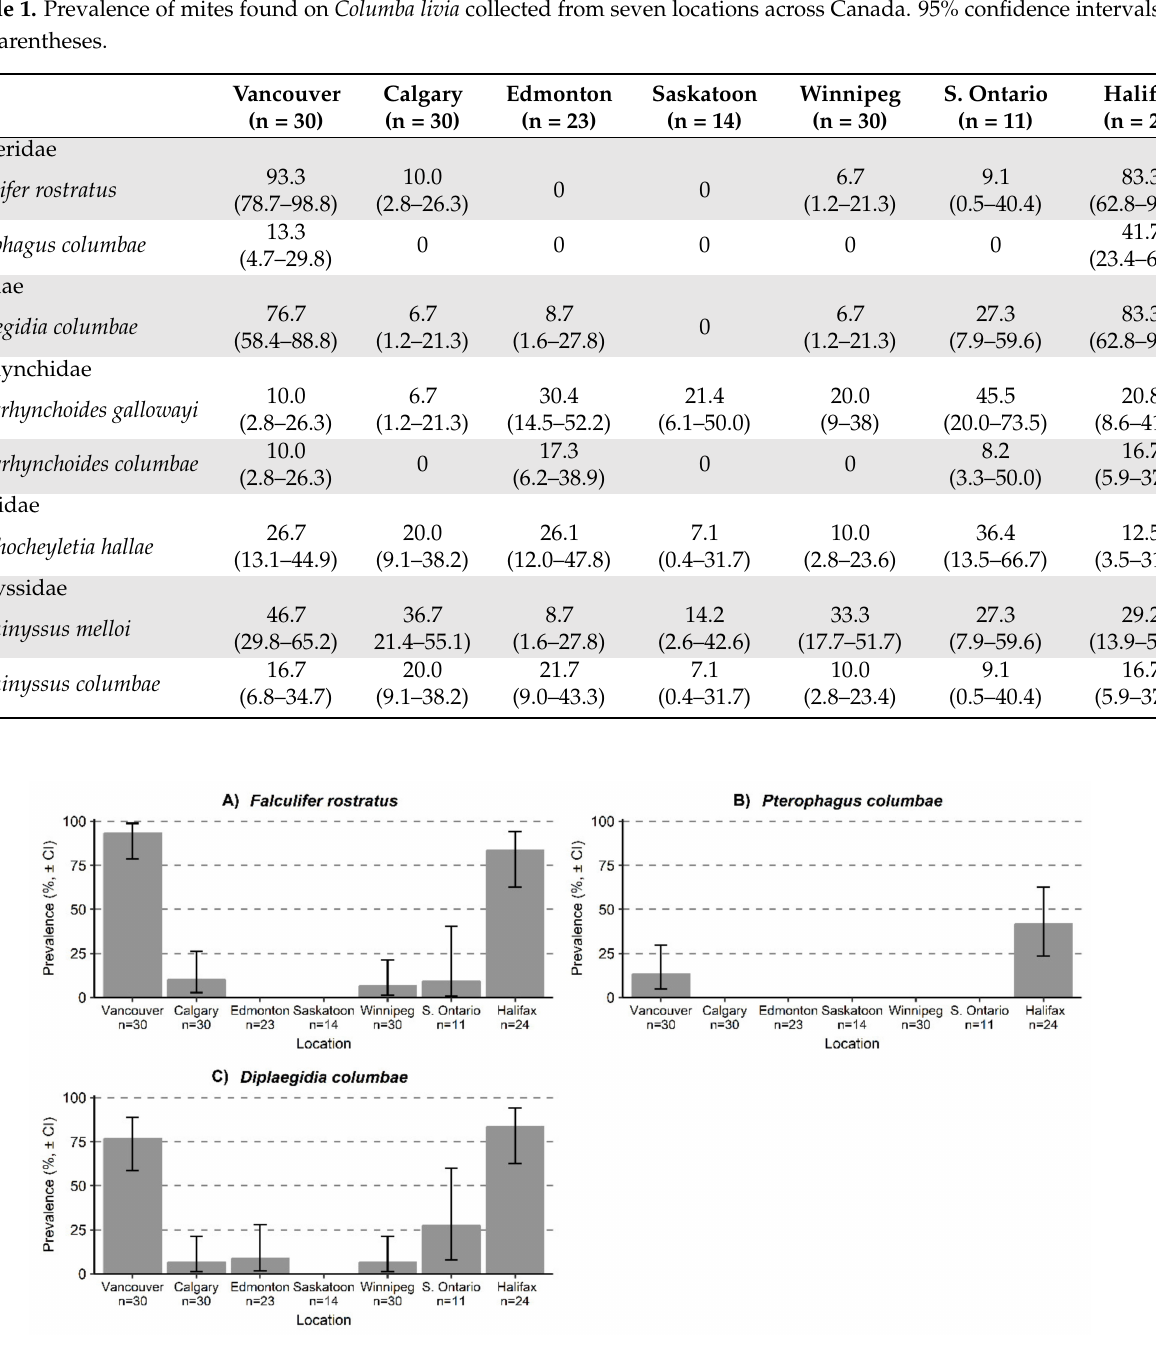
Figure 2. Prevalence of feather dwelling mites: ( A ) Falculifer rostratus, ( B ) Pterophagus columbae, and ( C ) Diplaegidia columbae infesting Columba livia sampled from seven locations across Canada, 95% confidence intervals. Sample sizes refer to number of C. livia examined from each